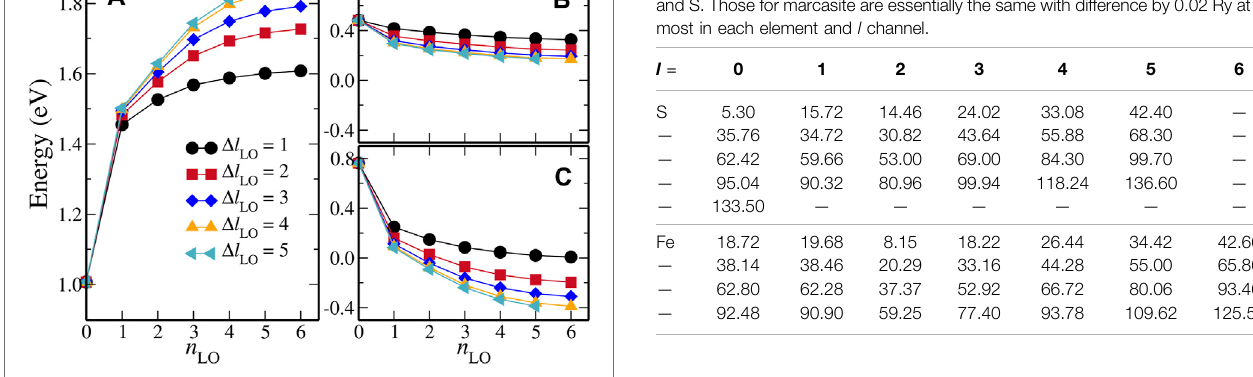
FIGURE 2 | Dependence on HLOs parameters of G 0 W 0 @PBE calculated (A) the indirect band gap between X and Γ , E X – Γ g , and self-energy corrections to (B) bottommost conduction state at the Γ point, Δ ϵ Γ c , and (C) topmost valence state at the X point, Δ ϵ X v , for marcasite FeS 2 .